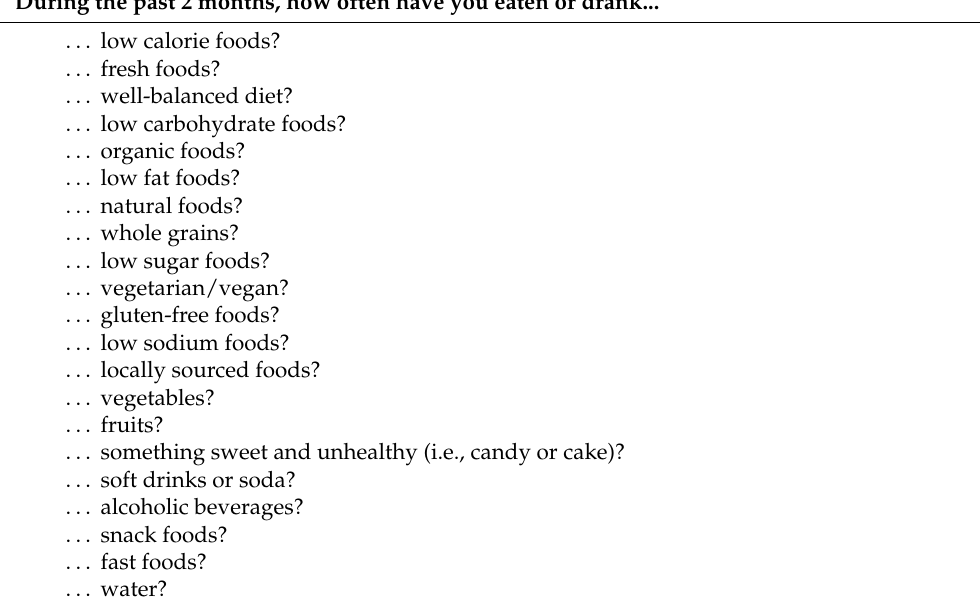
Table 2. Twenty-one questions about eating behaviors over the preceding two months over the FFQ. During the past 2 months, how often have you eaten or